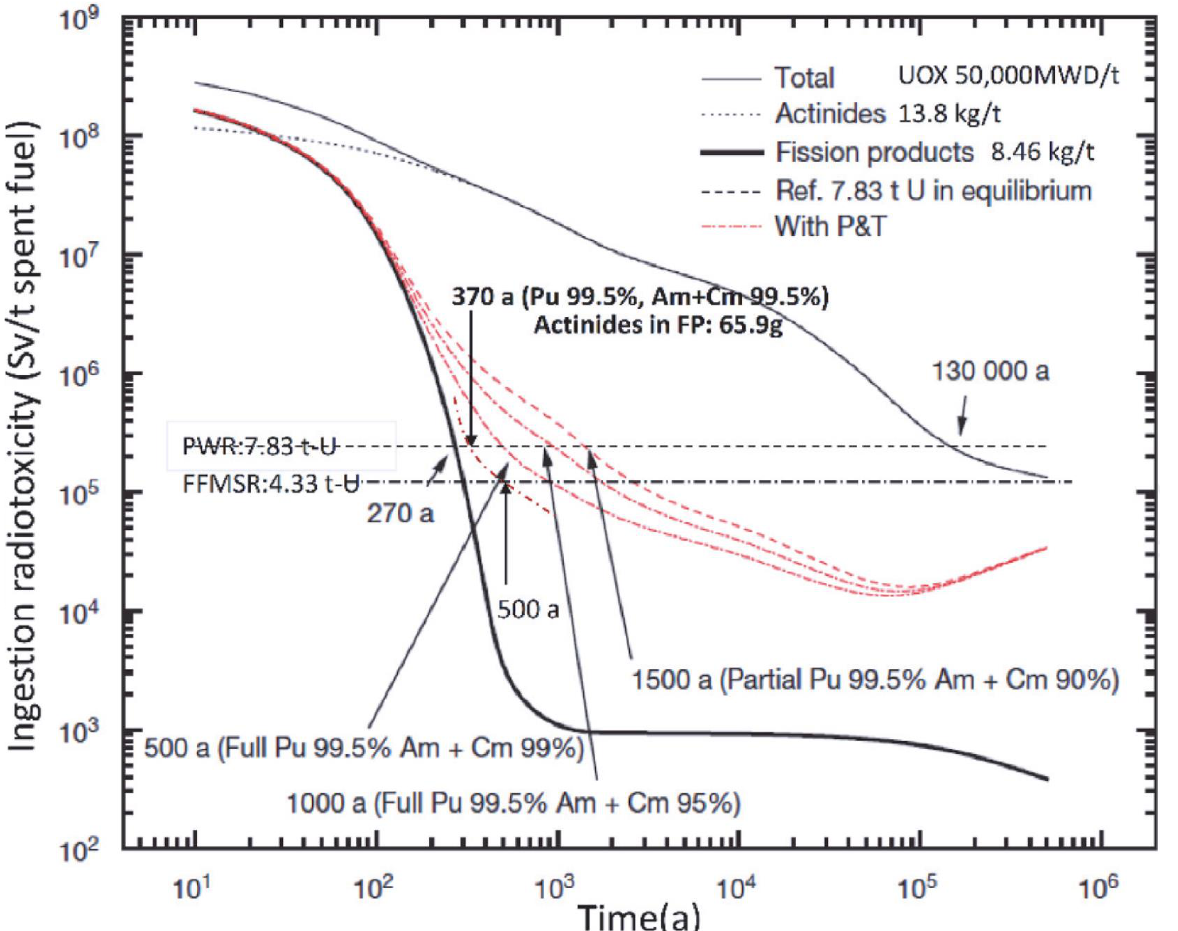
Figure 1. Radiotoxicity of nuclear waste over time and the effect of different efficiencies of the separation of plutonium and minor actinides, [23] intechopen, CC BY 3.0 .